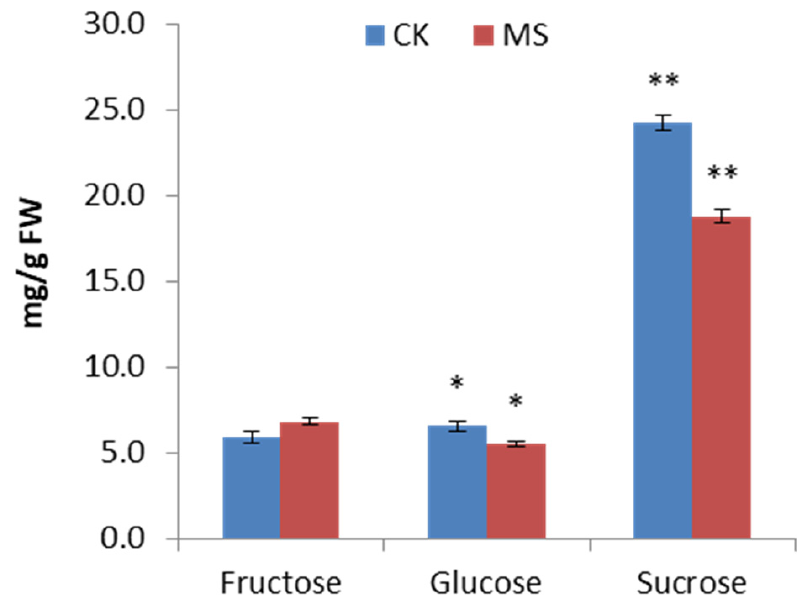
Figure 2. Contents of individual sugars in CK and MS pineapple flesh. CK: normal fruit; MS: mildly watercored fruit. ANOVA was used to compare the monosaccharide content between CK and MS; error bar represents the standard deviation of the three replicates. * p < 0.05, ** p < 0.01.